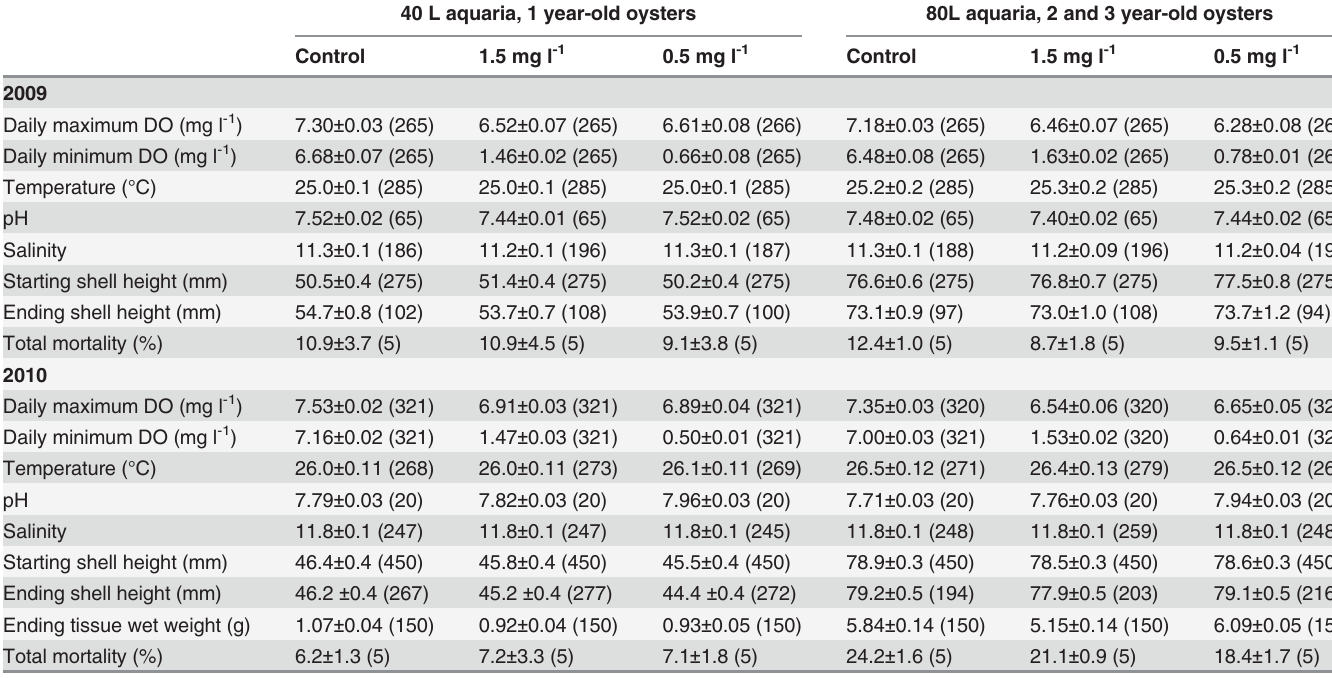
Means were calculated from daily mean, minimum or maximum values of replicate measurements within each aquarium averaged over all dates on which DO concentrations were manipulated. Because of low variation among aquaria of similar sizes, temperature and salinity were not always measured in all aquaria each day. In 2010, pH was measured in all tanks near the end of the low plateau period on 4